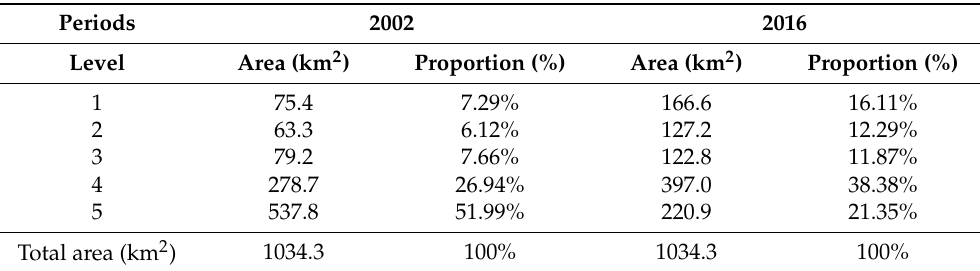
Table 1. The area proportion of different vegetation coverage levels in the mining affected area in 2002 and 2016.